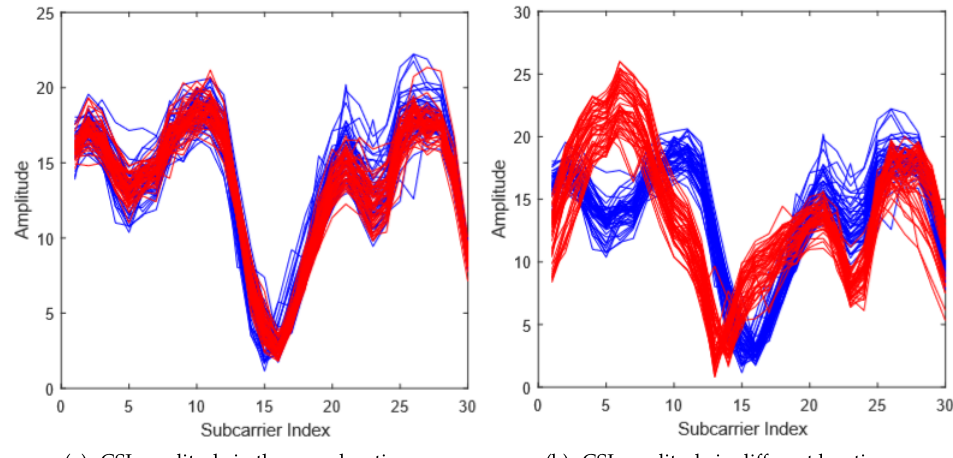
Figure 1. The CSI amplitude comparison.